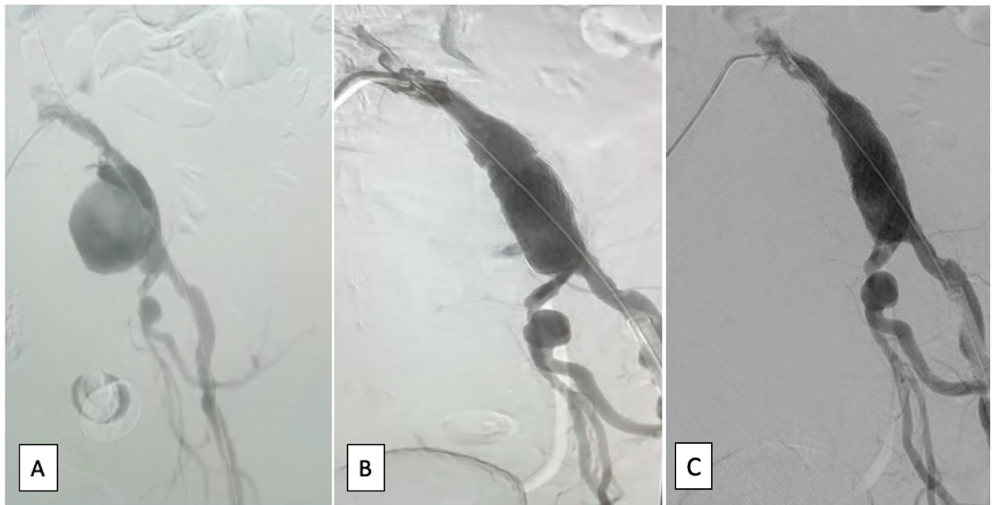
Figure 3. Angiographic image: ( A )—periprocedural, left common iliac artery aneurysm; ( B )—inter ‐ mediate image with excluded left common iliac artery aneurysm and the implanted stent graft and leak; ( C )—excellent end result.